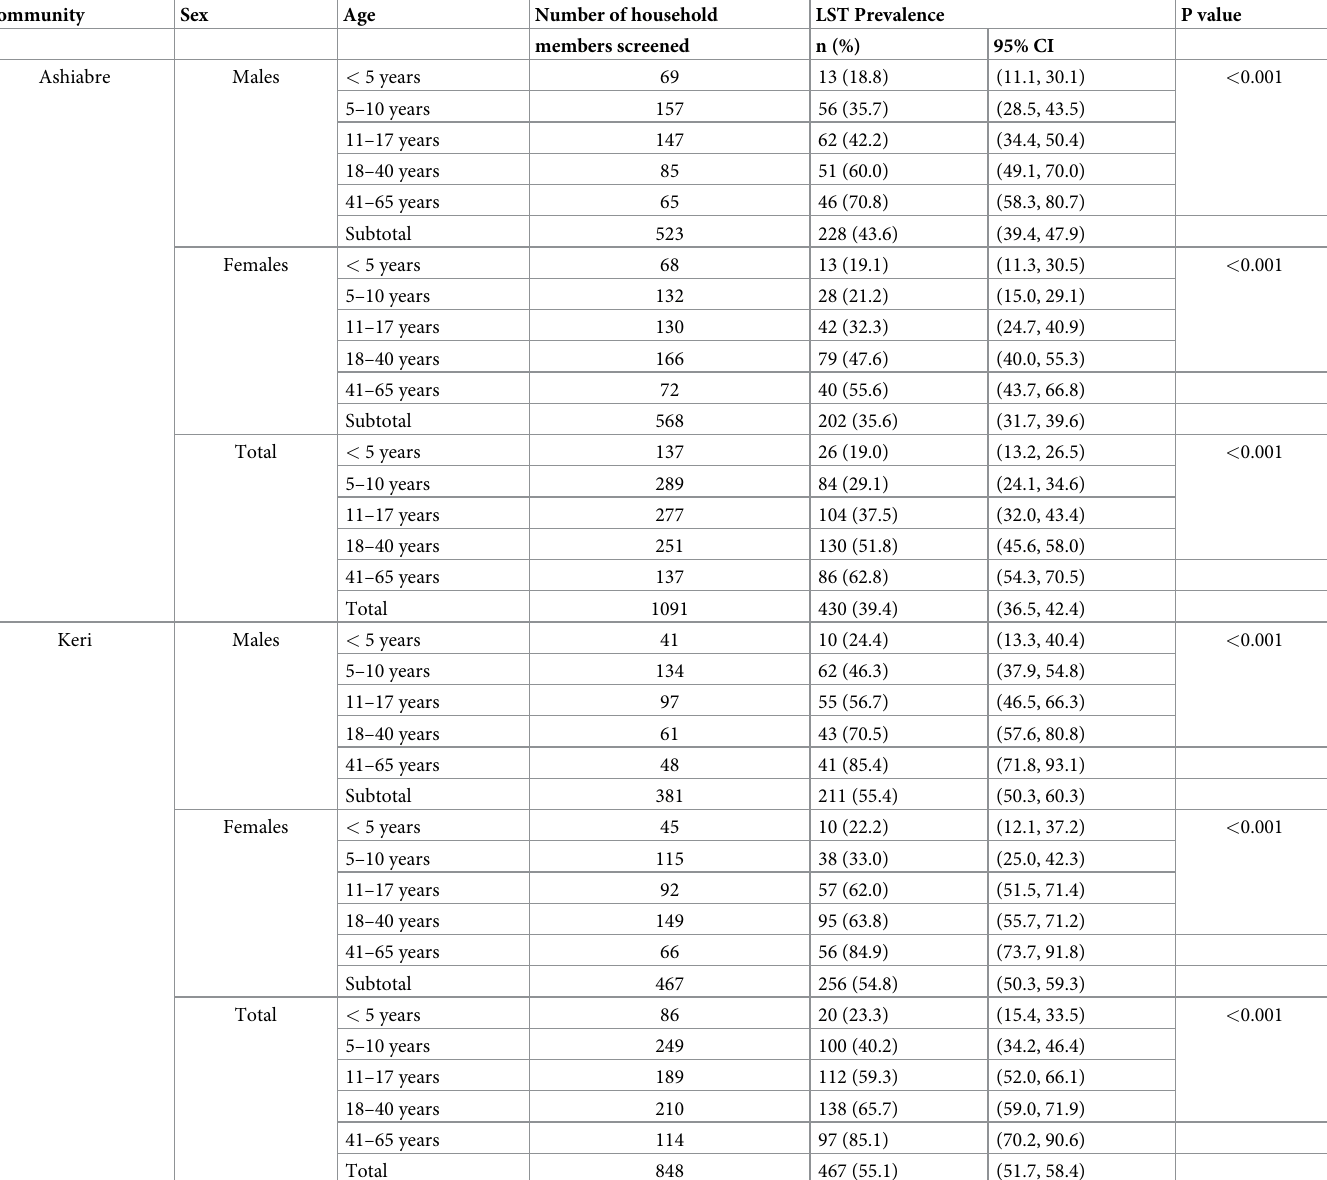
Table 2. LST prevalence by age and sex at Ashiabre and Keri.